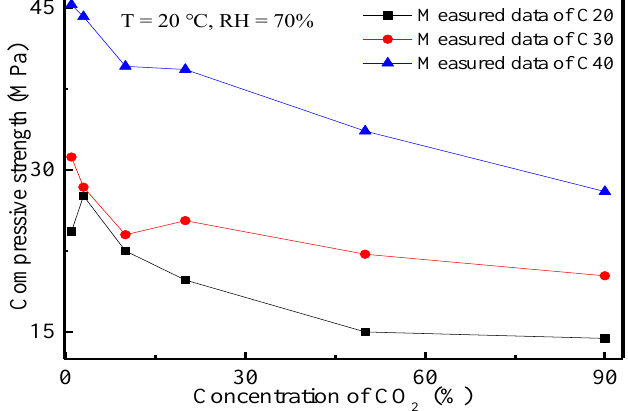
Figure 6. Relation curves between the compressive strength of concrete and CO 2 concentration.